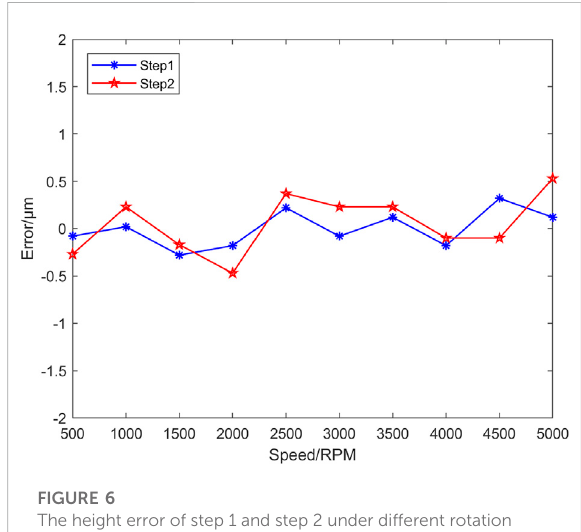
FIGURE 4 Frequency-domain clearance measurement signal.